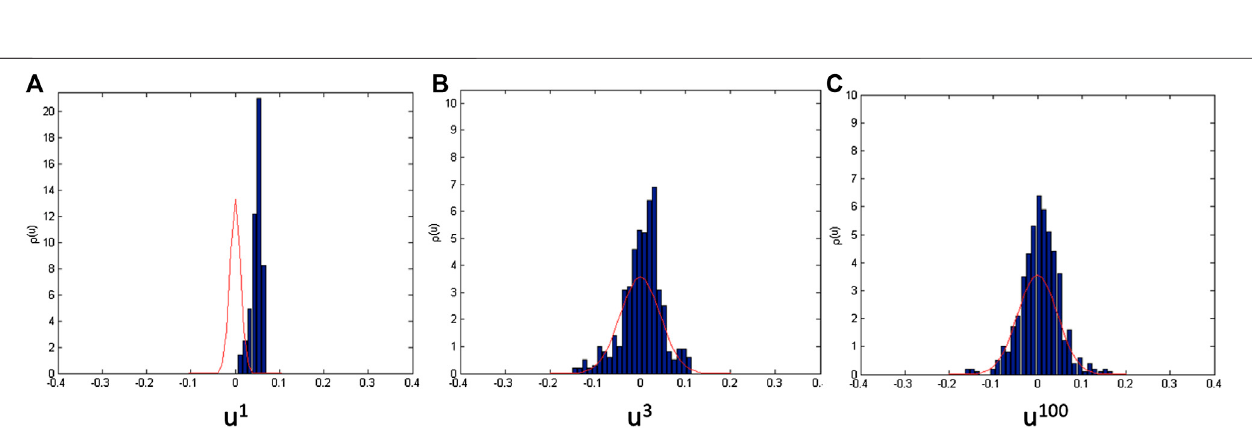
FIGURE4| Thedistribution ofeigenvaluesfromthe C matrixand the R matrix. Thebluecolorrepresentsthedistribution oftheeigenvaluesofthematrix C ,and the red one shows the distribution of the eigenvalues of the matrix R on the S&P 500 daily stock price data for the period of January 1, 2007 until October 28, 2016. (A) eigenvalue in the scale for λ of 1 ‒ 200 and (B) The eigenvalue in the zoomed scale for λ of 1-20.